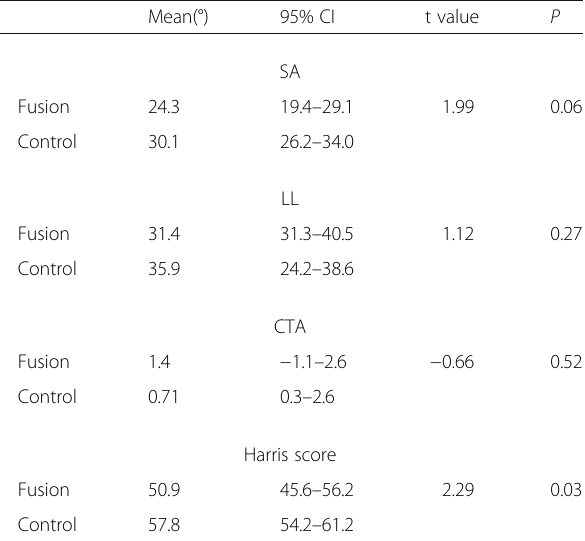
Table 1 The SA, LL and CTA in the lumbar fusion and control group were similar without a statistically significant difference.